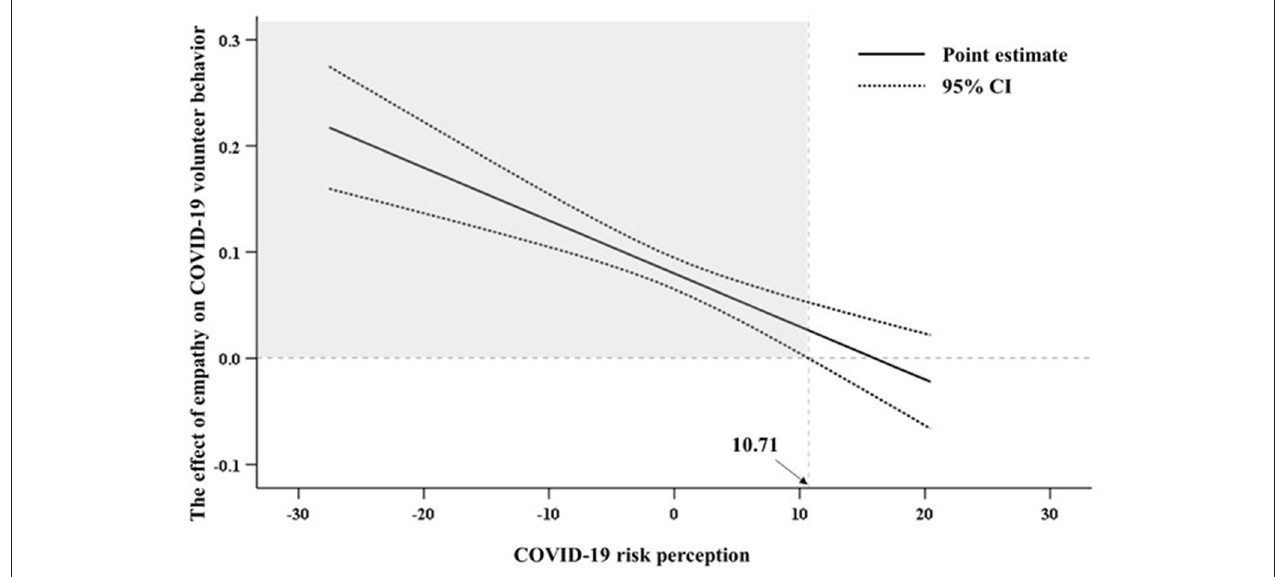
FIGURE 2 | Effect of empathy on COVID-19 volunteer behavior with Johnson-Neyman confidence